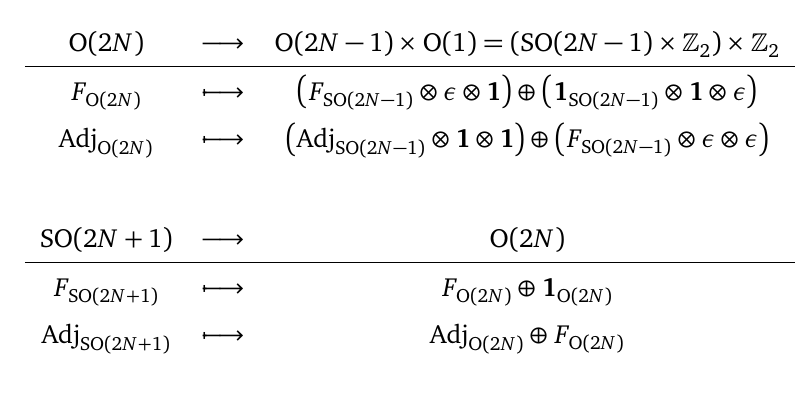
Table 1: Summary of branching rules for O ( N )